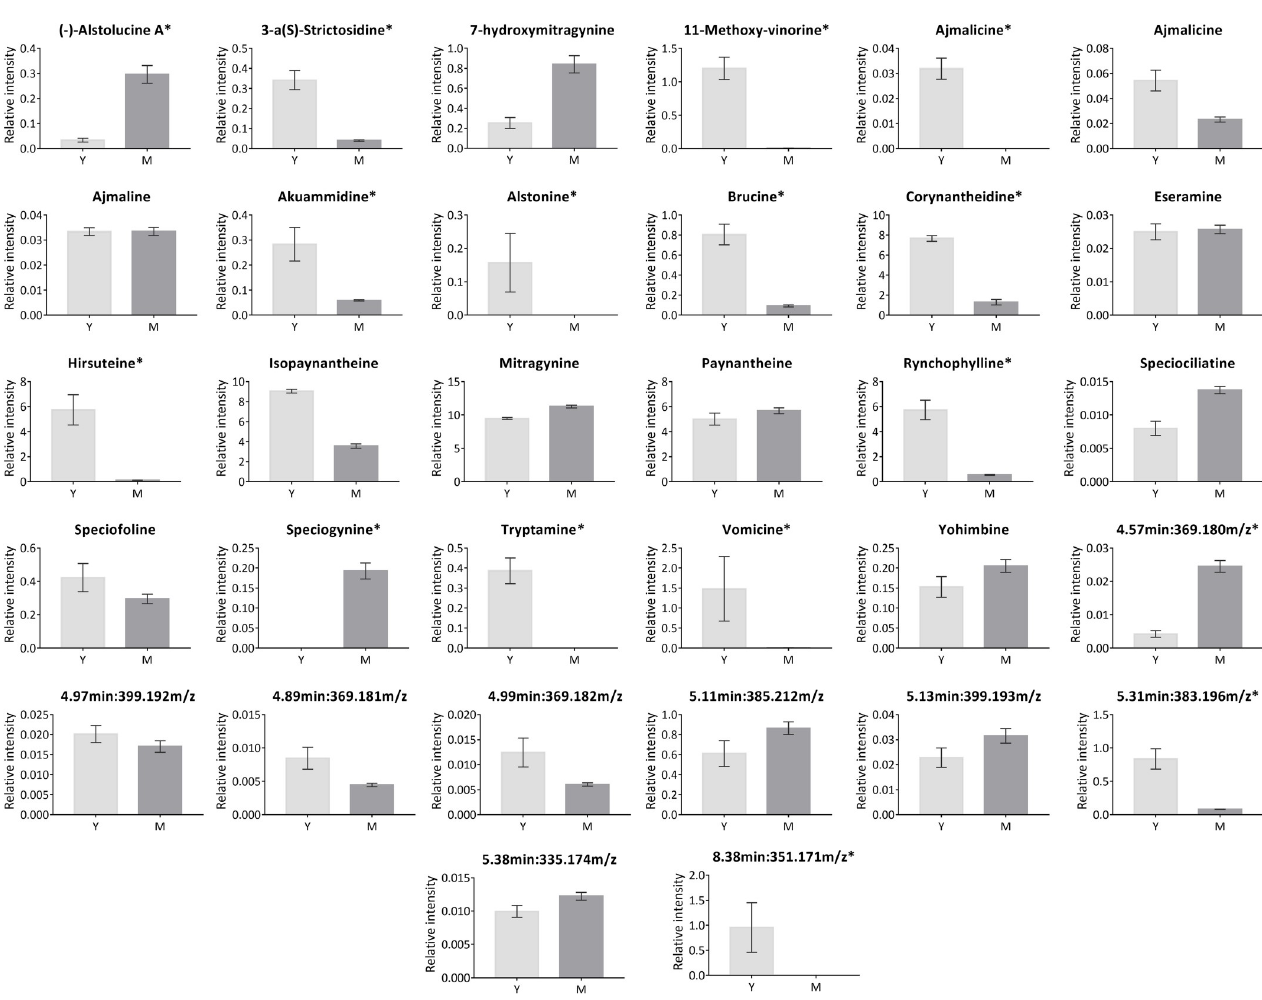
Fig 6. Relative abundance of 32 indole alkaloids putatively identified in young and mature leaves of M . speciosa . Relative intensity values for all indole alkaloids are provided in the S3 Table. Asterisks ( � ) indicate highly differential metabolites ( � FDR < 0.05, |Log 2 FC| > 2). The graphs are arranged in alphabetical order. RT:m/z values are provided instead of compound names for metabolite features annotated to more than one compound, which can be referred to in the S3 Table.